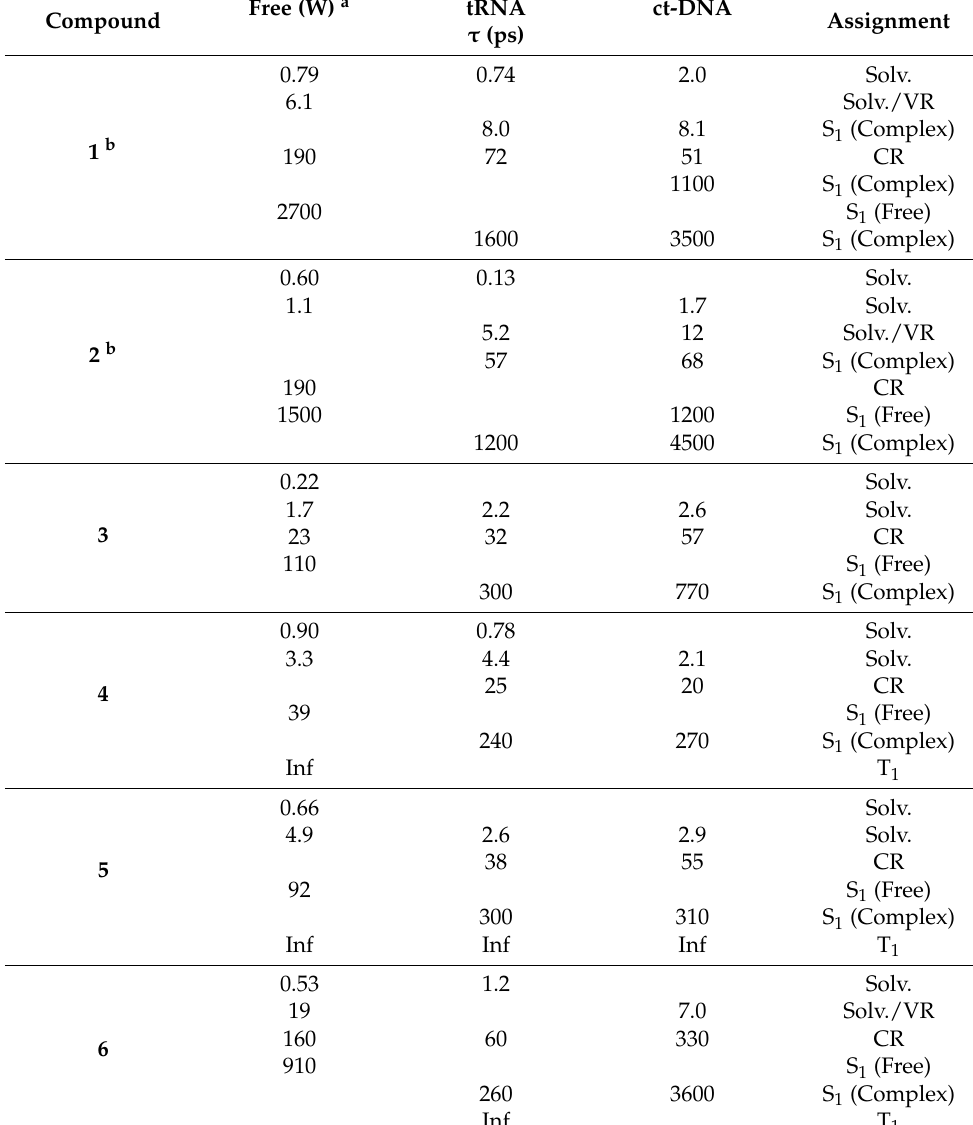
Table 3. Excited-state properties of compounds 1–6 in water (W) with 5% DMSO, complexed with tRNA and ct-DNA [r ([compound]/[nucleic acid]) = 0.005] in ETN buffer solution, obtained by ultrafast transient absorption (TA) ( λ exc = 400